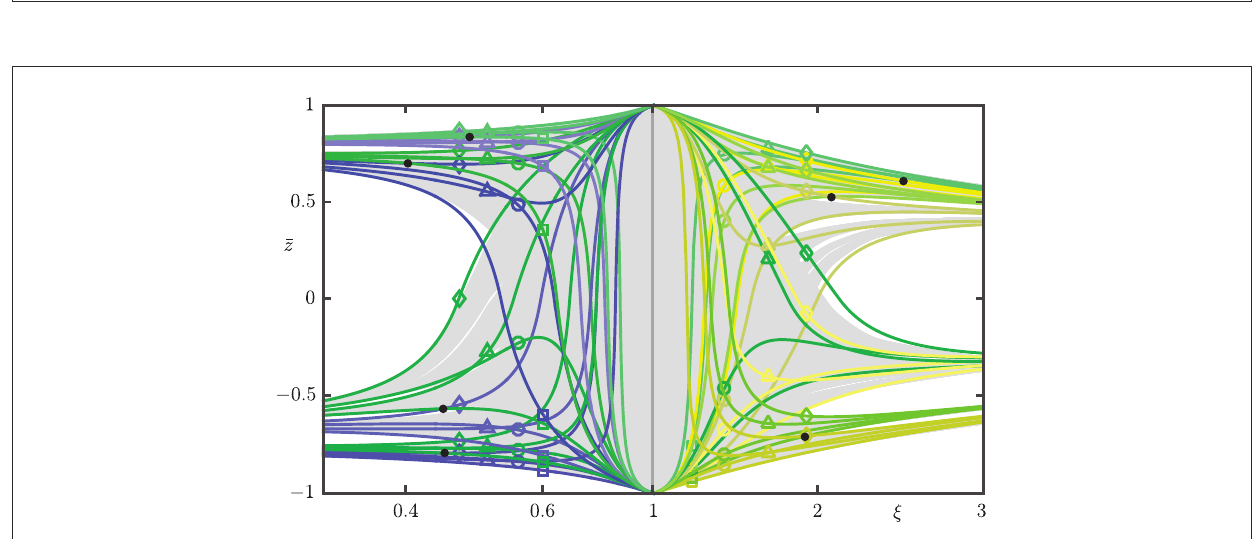
FIGURE13 Curves # ¯ z ( ξ ), 3 ¯ z ( ξ ), (cid:3) ¯ z ( ξ ), and △ ¯ z ( ξ ) for the sub-boxes D ±∓± and B ±∓± shown with W u ( p ± ) ∩ 6 and W s ( p ± ) ∩ 6 as in Figure